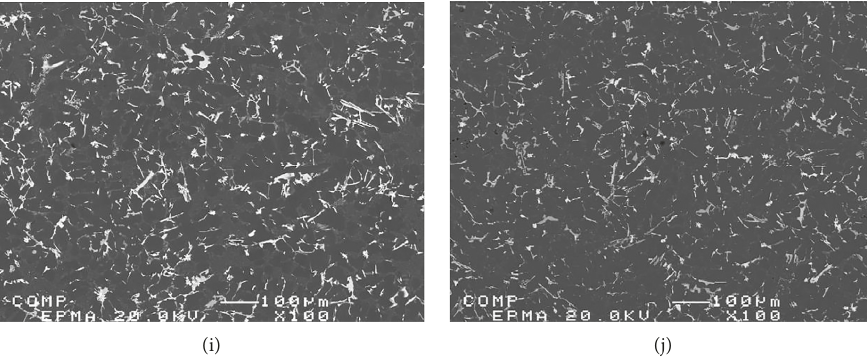
Figure 1: Backscattered electron images for as-cast (left) and solution heat-treated (right) conditions of the alloys studied: (a, b) M1S (base alloy), (c, d) M2S (2wt.% Ni), (e, f) M3S (0.75 wt.% Mn), (g, h) M4S (4wt.% Ni), and (i, j) M5S (2wt.% Ni + 0.75 wt.%